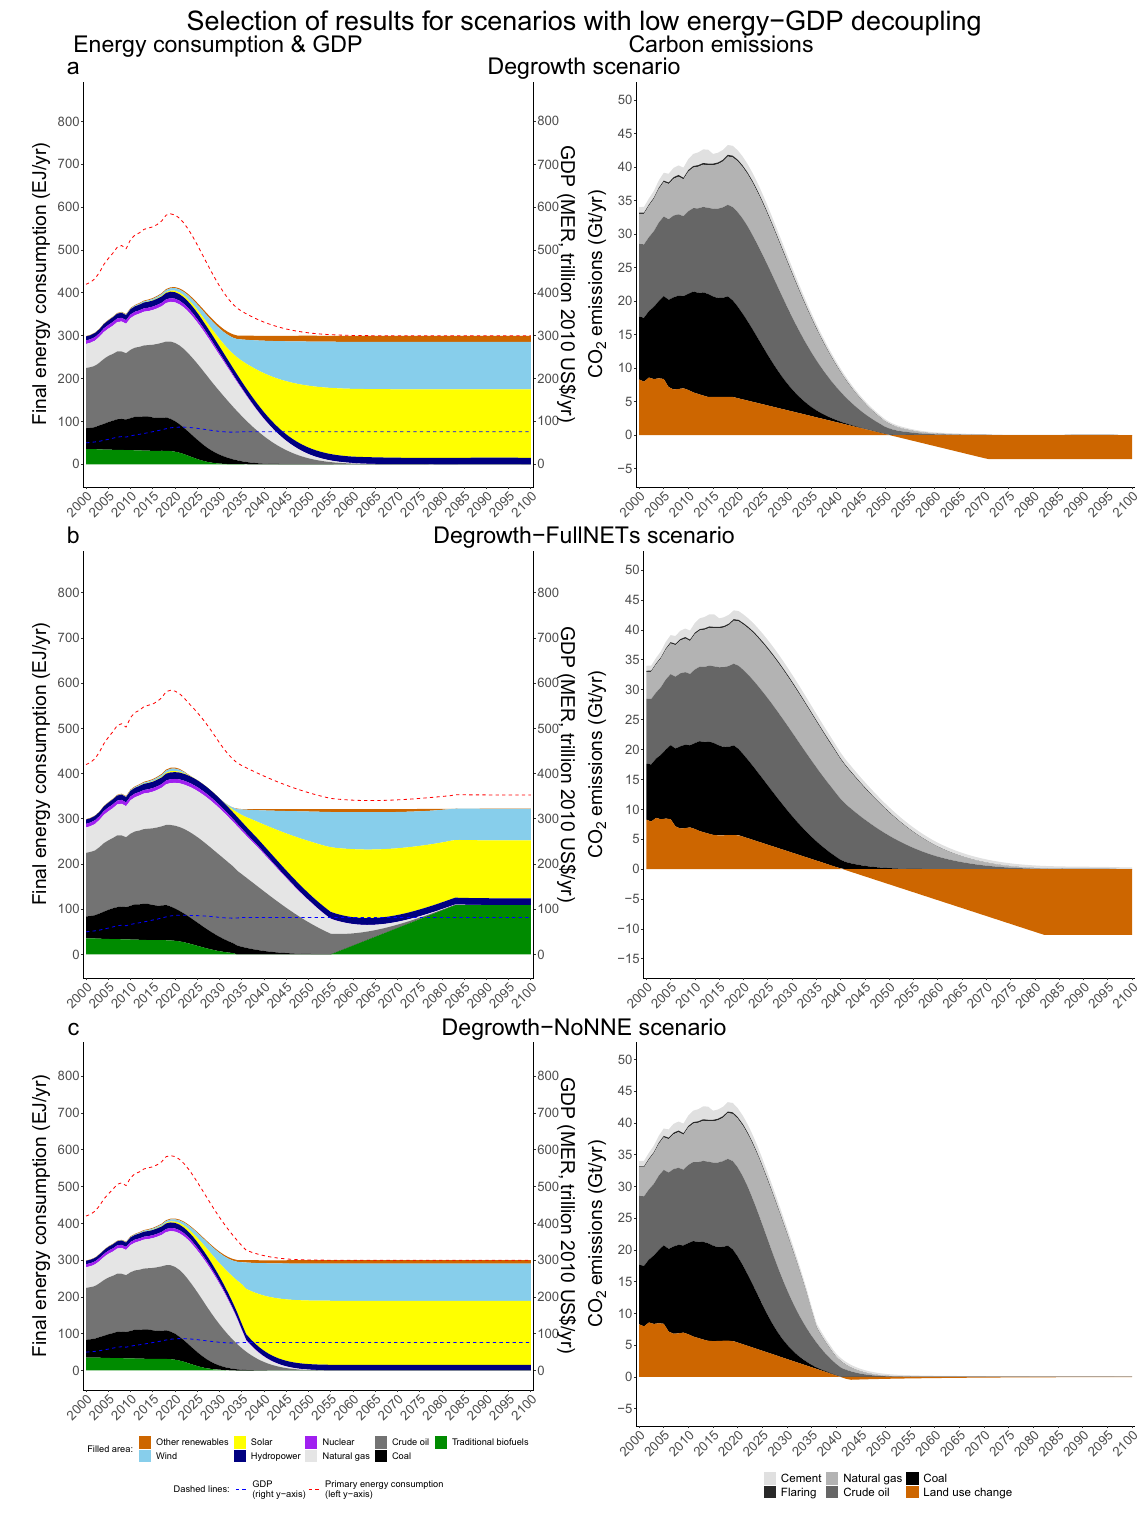
Fig. 2 Selection of 1.5°C scenarios with low energy-GDP decoupling. Selection of 1.5 °C scenarios with low energy-GDP decoupling ( a – c ). On the left, fi nal energy consumption (in EJ, left axis), aggregate primary energy consumption (in EJ, red dashed line, left axis) and GDP (MER, in trillion 2010 US$, blue dashed line, right axis). On the right, carbon emissions (in GtCO 2 /yr). The full collection of scenarios can be found in Supplementary Fig.